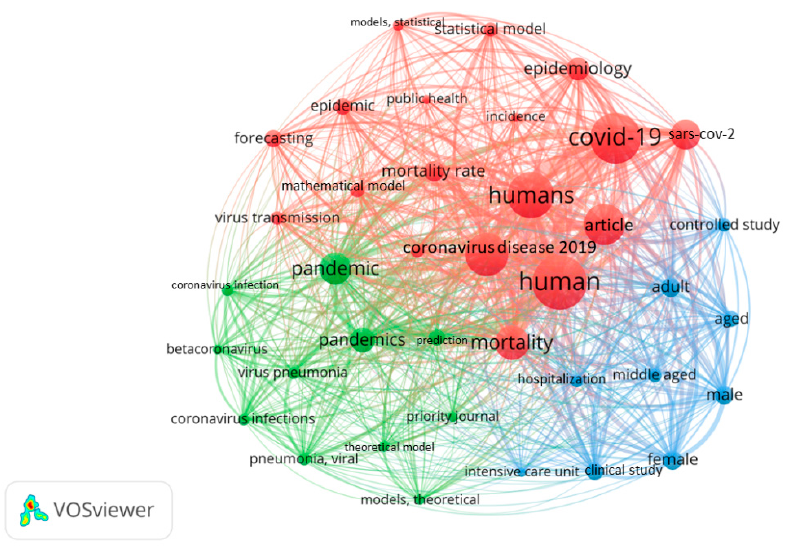
Figure 6. Graphical representation of Lee–Carter model as discussed in Section 3.4.4. (McNown and Rogers (1989), Heligman and Pollard (1980), Lee and Carter (1992), Lee (1993), Brouhns et al. (2002), Li and Lee (2005), Currie (2006), Koissi and Shapiro (2006), Renshaw and Haberman (2006), Hyndman and Ullah (2007), Booth and Tickle, 2008, Cairns et al. (2008), Härdle and Myši č ková (2009), Plat (2009), Cairns et al. (2011), Hanewald (2011), Li and Hardy (2011), Niu and Melenberg (2014), Demirel and Basak (2017), Seklecka et al. (2017), Tsai and Lin (2017), Bozikas and Pitselis (2018), Nor et al. (2018), Villegas et al. (2018), Yue et al. (2018), Andrés ‐ Sánchez and Puchades (2019), Levantesi and Pizzorusso (2019)).